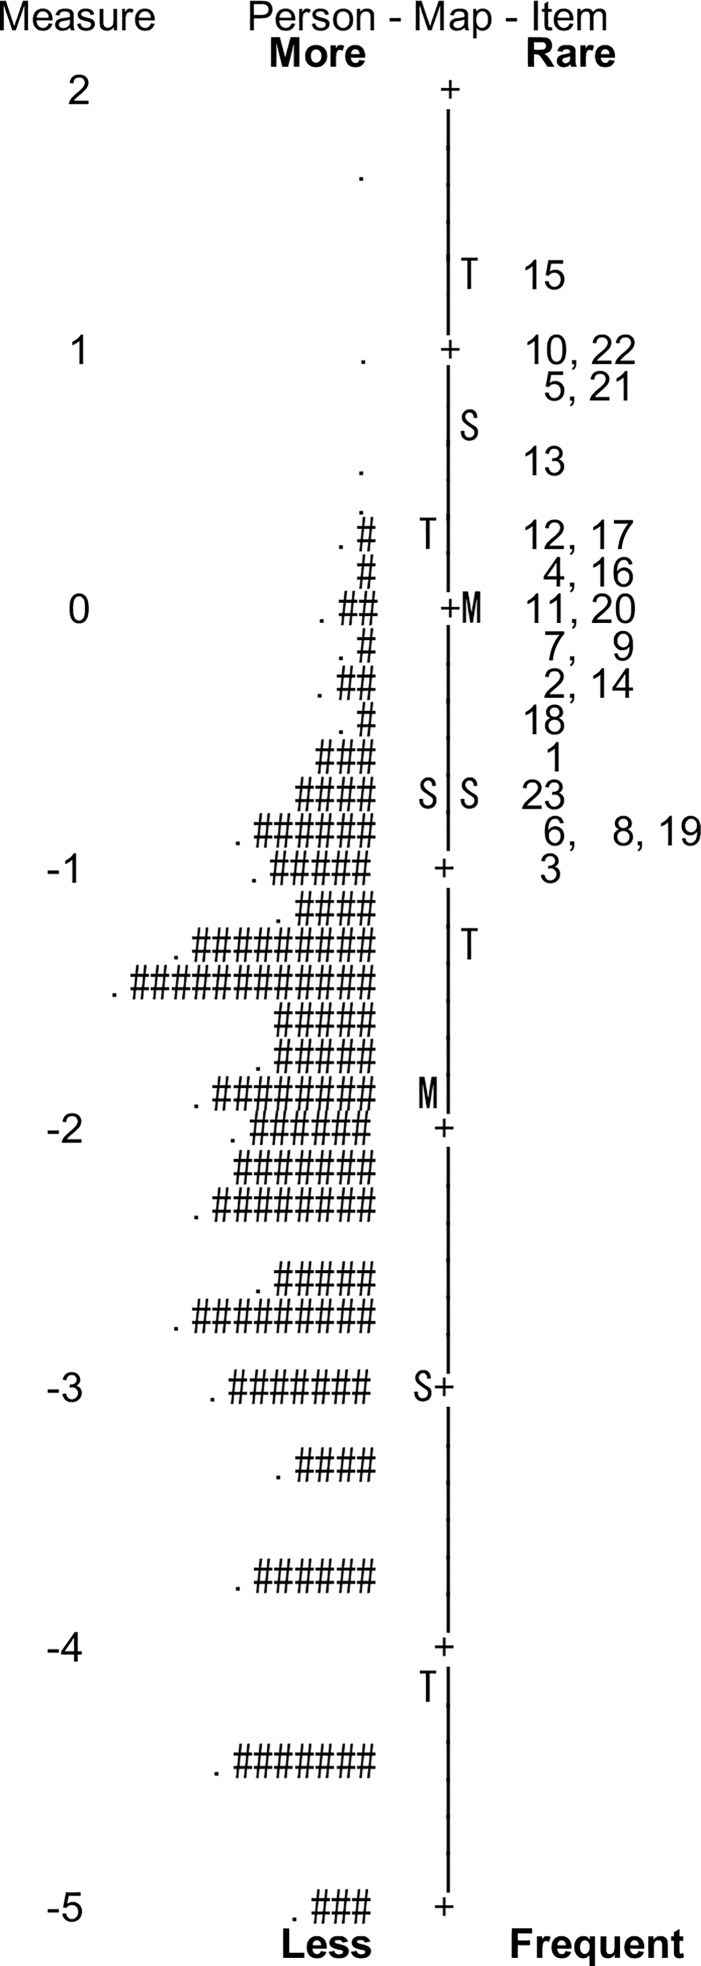
Person-item map of the Japanese version of the Visual Discomfort Scale.Person locations are displayed on the left column, while item locations are displayed on the right. Each hash represents three participants, and each period represents one or two participants. Numbers on the right column correspond to the item numbers of the Visual Discomfort Scale. M: mean; S: one standard deviation from the mean; T: two standard deviations from the mean.